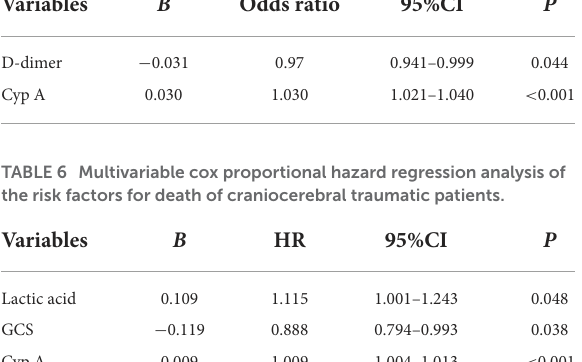
TABLE 5 Binary logistic regression analysis of the risk factors with poor neurologic outcome. Variables